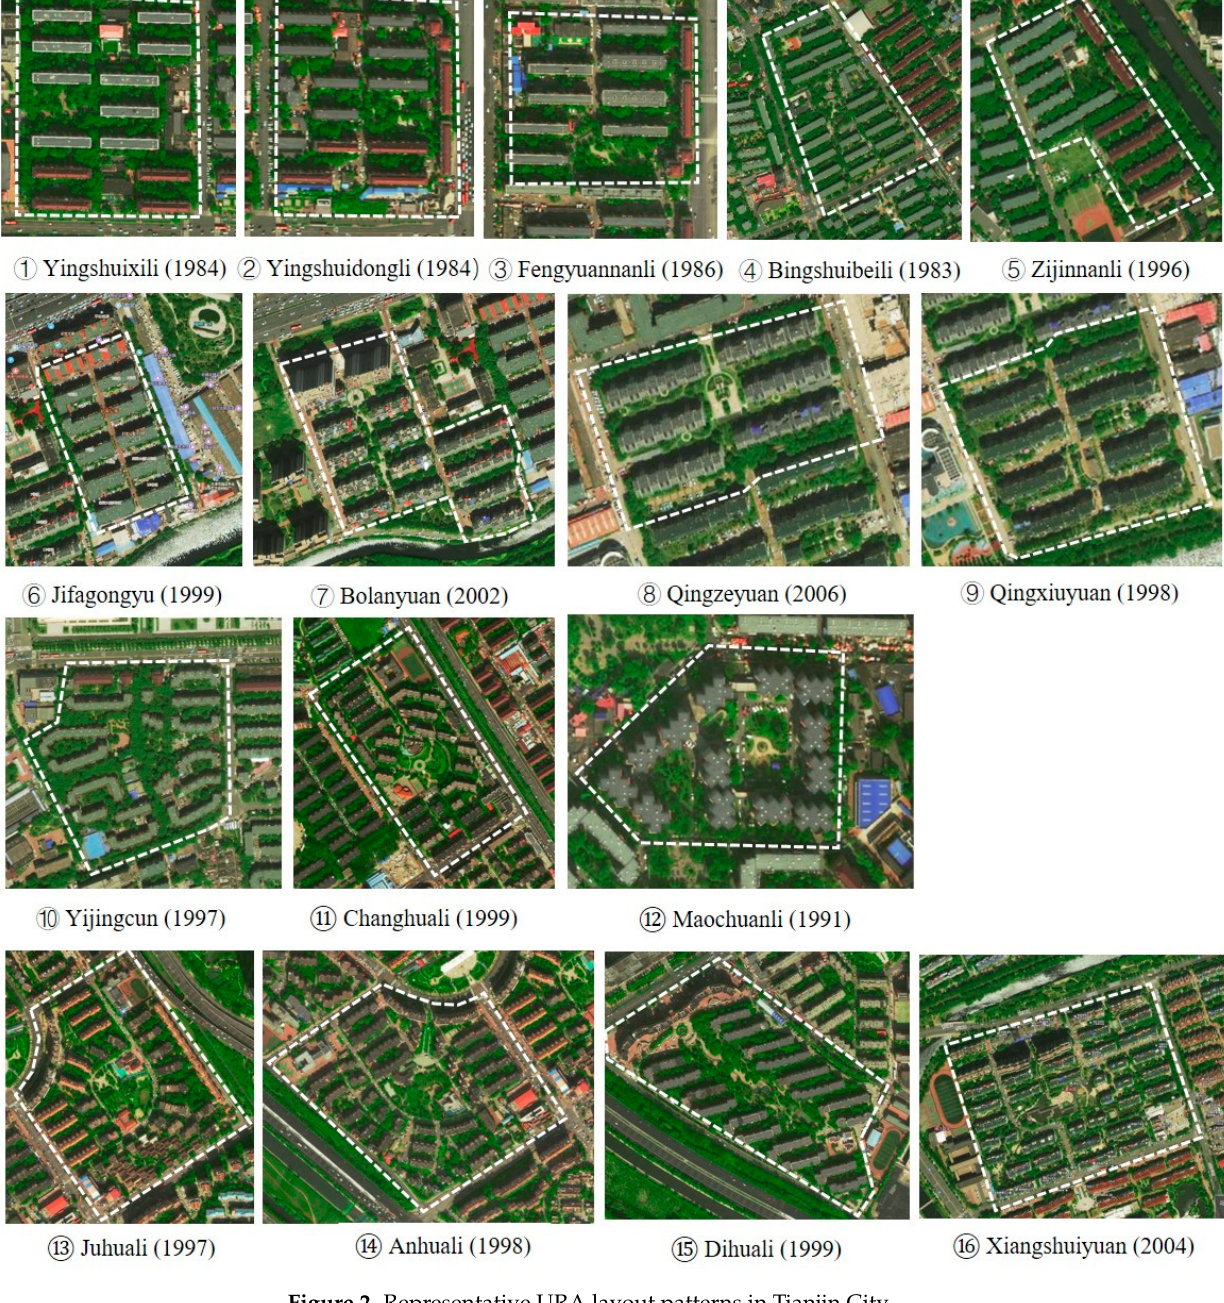
Figure 2. Representative URA layout patterns in Tianjin City.